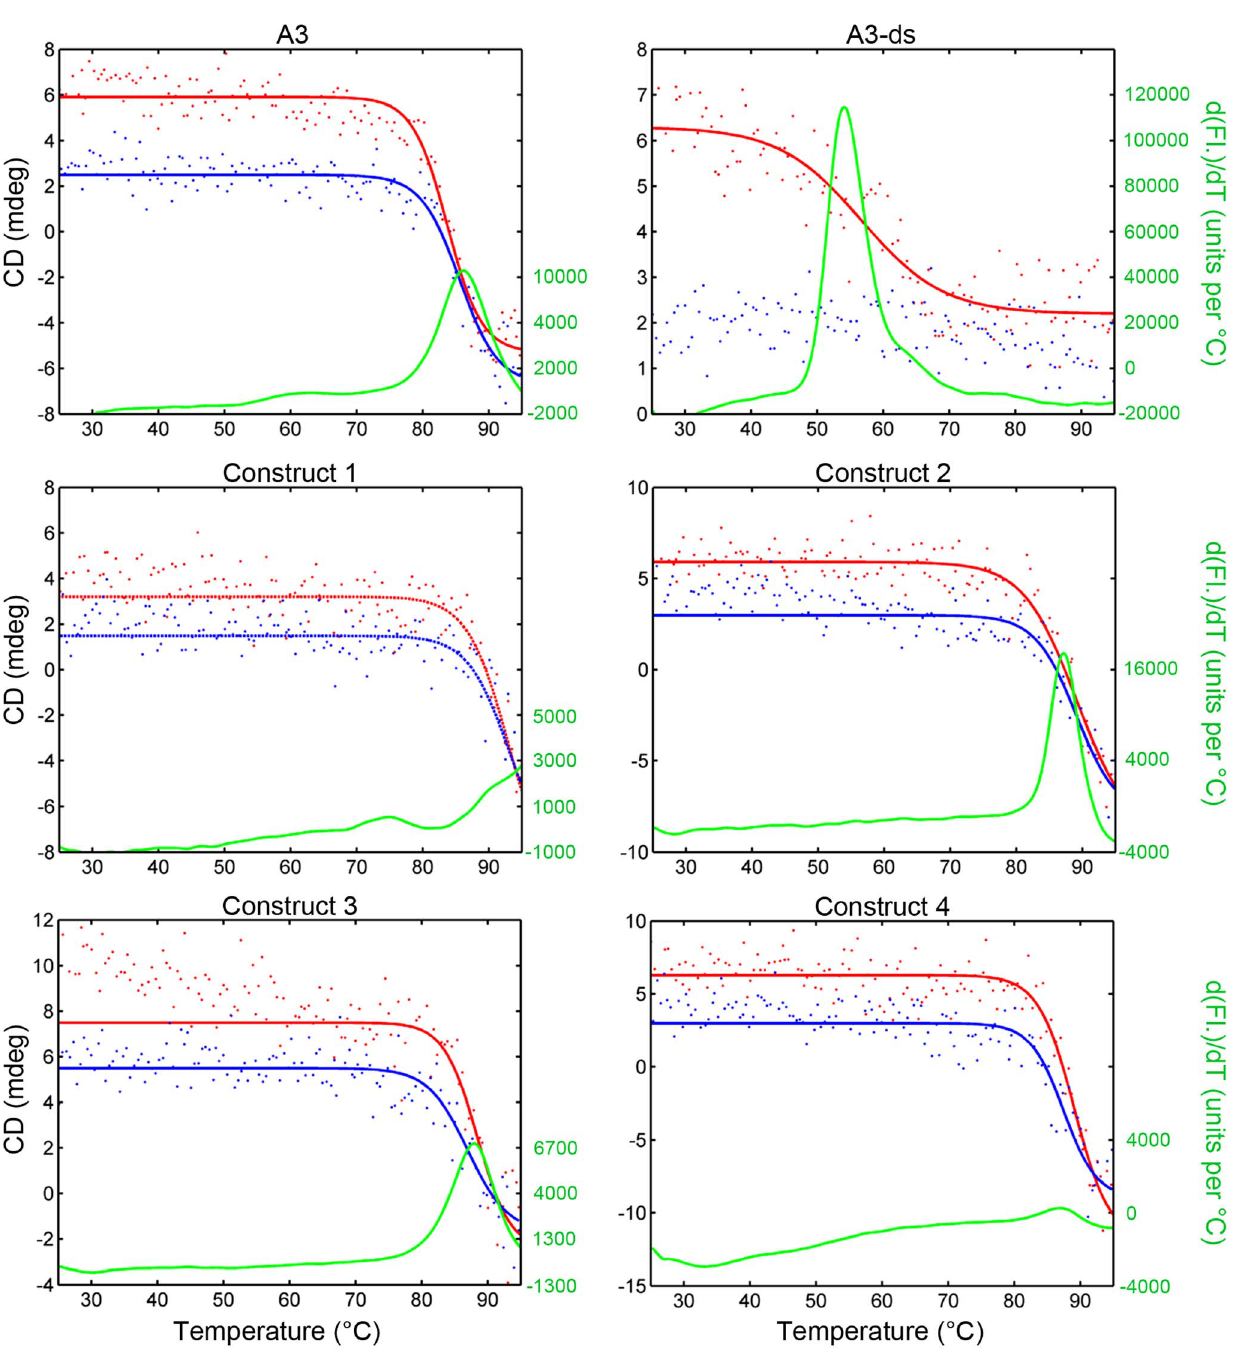
Fig. 2. The thermal stability of sdAb A3 and constructs. CD and a fluorescent dye method were used to determine the melting point of the antibodies. CD is represented by red (heating) and blue (cooling) points. The solid lines are a sigmoidal curve fit. See text for an explanation of the dotted lines for Construct 1. The green line is the first derivative of the fluorescence in the dye method. The melting temperature is taken to be the inflection point in the CD heating curve. The dye method peak is in close agreement in most cases.